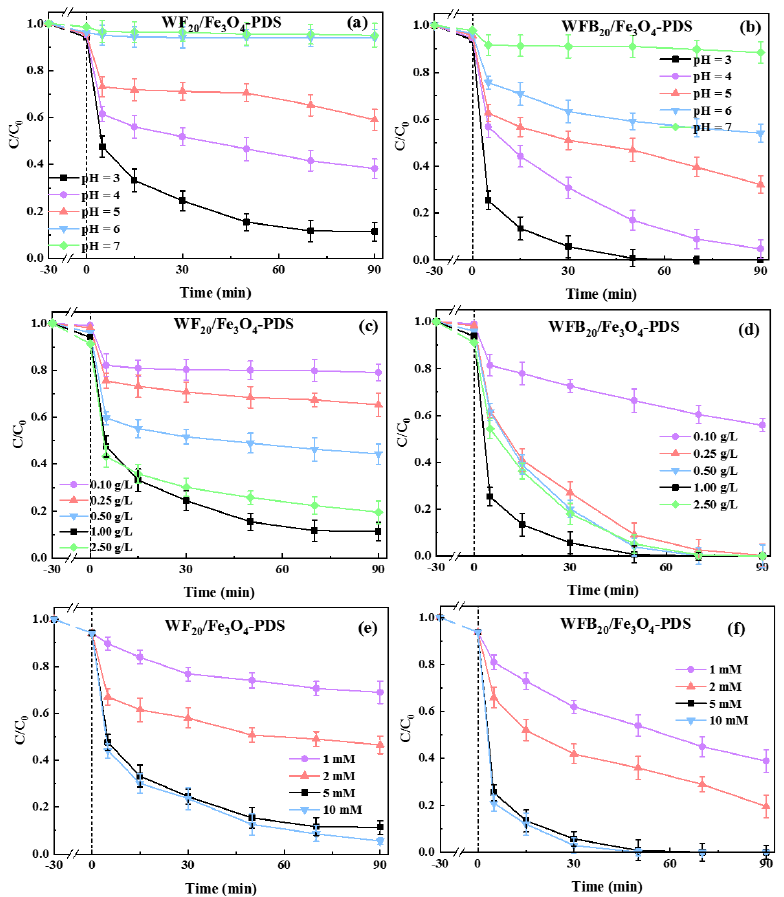
Figure 5. Effects of ( a , b ) the initial solution pH, ( c , d ) catalyst dosage, and ( e , f ) PDS concentration on the degradation of BPA in WF 20 /Fe 3 O 4 -PDS and WFB 20 /Fe 3 O 4 -PDS processes (conditions: catalyst 1.0 g/L, [PDS] 0 = 5.0 mM, [BPA] 0 = 0.02 mM, pH 0 = 3.00 ± 0.1).